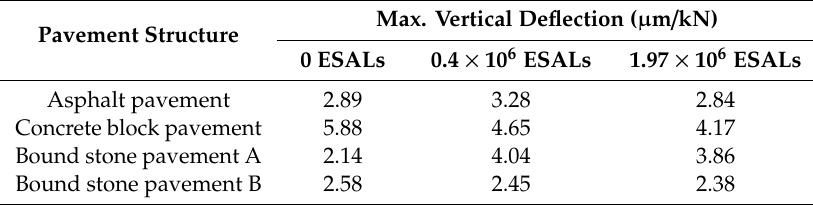
Figure 6. Rut depth measurement. Table 10. Maximum vertical deflection